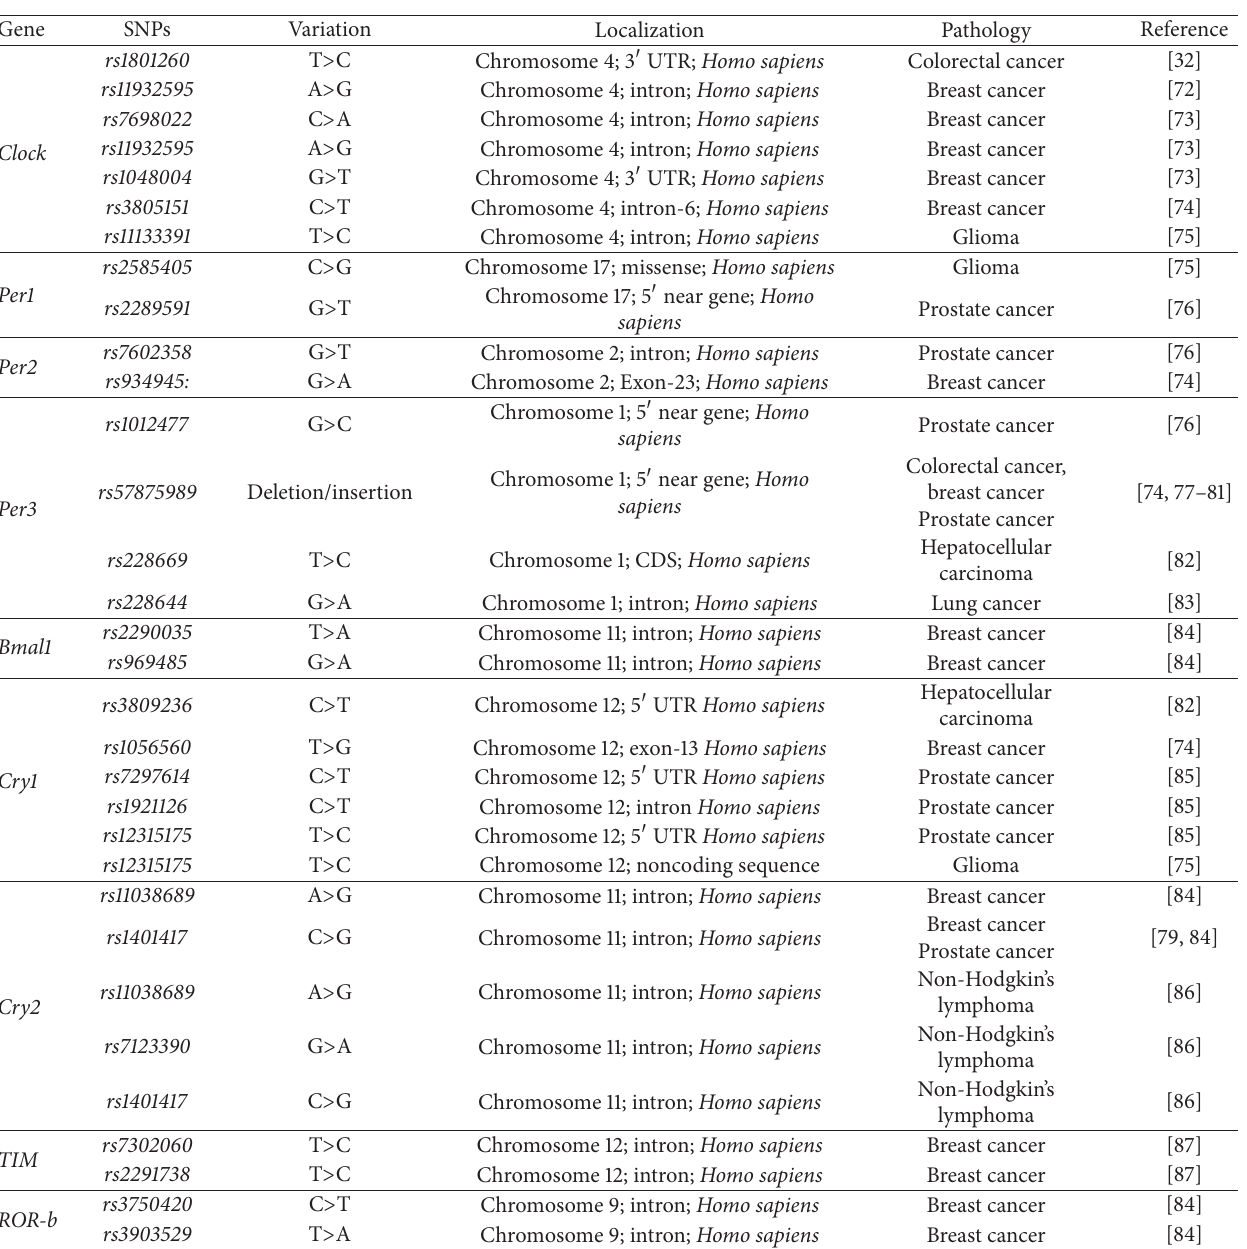
Table 3: Polymorphisms of clock genes associated with